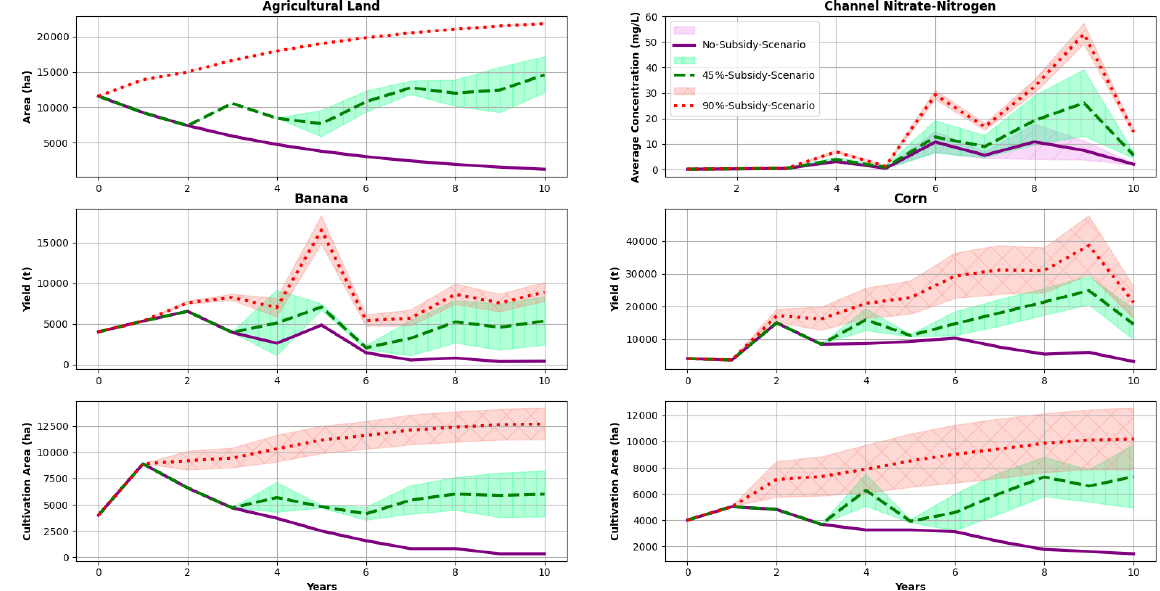
Figure 4. The results from the coupled models with 0%, 45%, and 90% subsidized fertilizer. In total, 10 runs were performed. The mean and standard deviation (shaded area) are